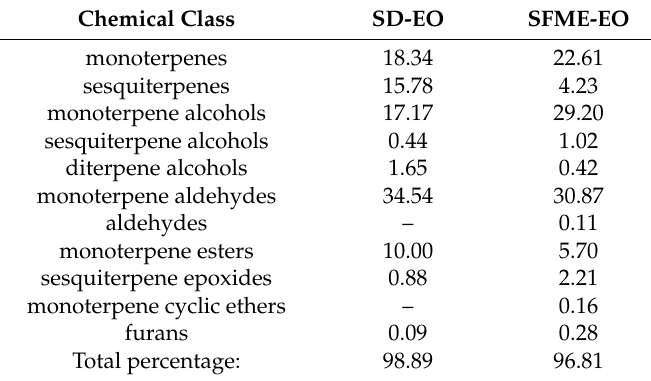
Table 2. Percentage a of various chemical classes of compounds in ‘Mato Peiyu’ leaf essential